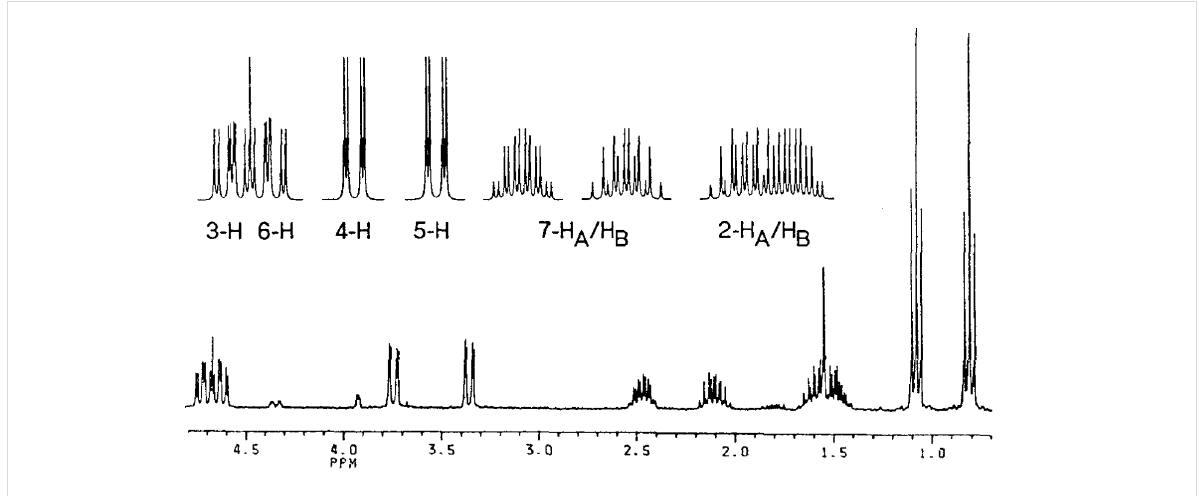
Figure 2: 1 H NMR spectrum of 18b (without aromatic H); below experimental spectrum, above: simulated signals for 2-H to 7-H.